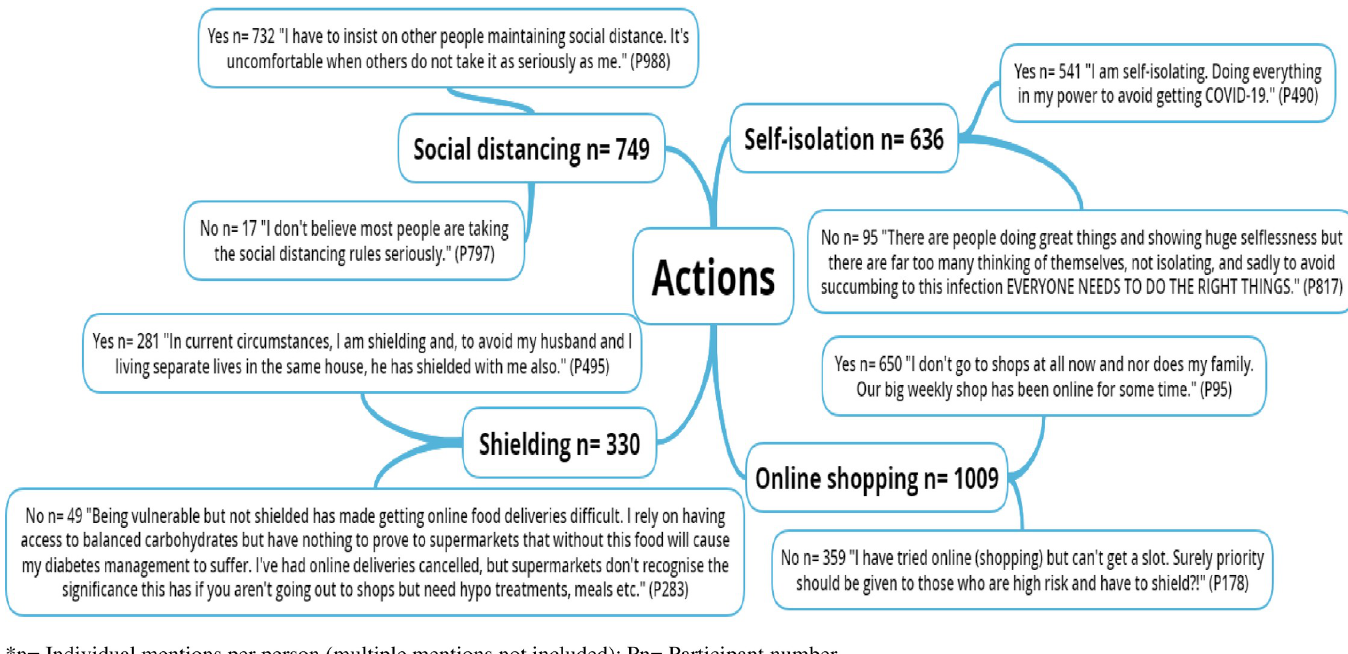
Fig 3. Exploring the actions of UK adults at high risk of severe illness during the COVID-19 lockdown.